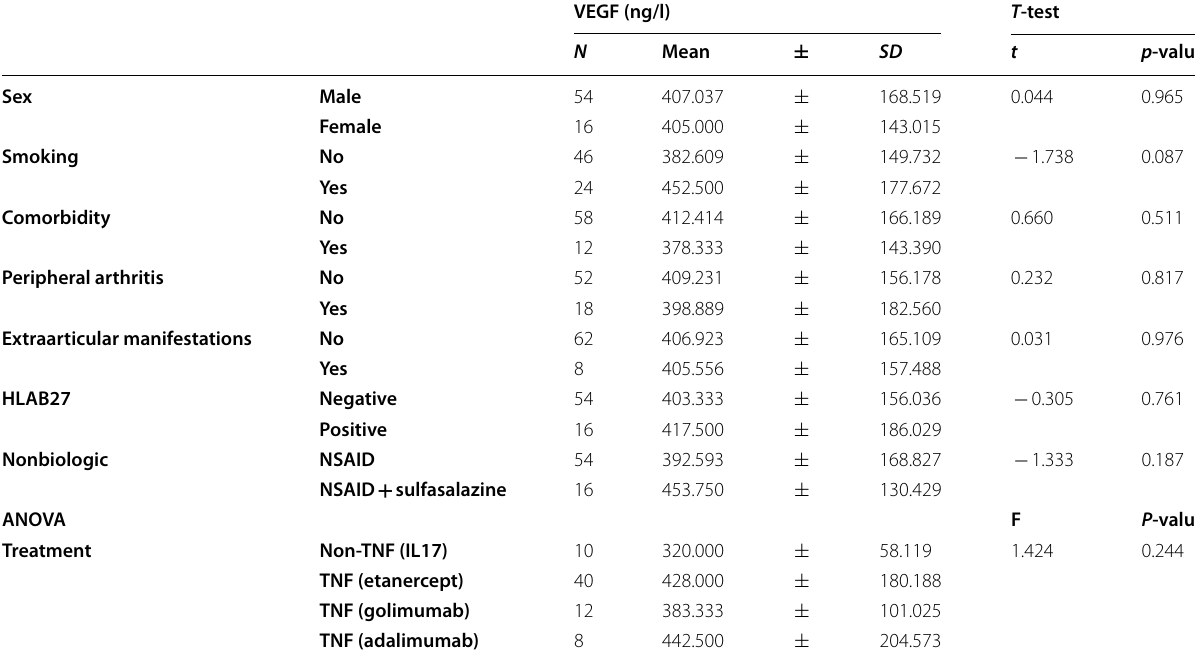
HLA Human leucocyte antigen, VEGF Vascular endothelial growth factor, ASDAS Ankylosing Spondylitis Disease Activity Score, NSAID Nonsteroidal anti-inflammatory drugs, TNF Tumor necrosis factor. SD Standard deviation P -values 0.05 are significant, and P -values 0.01 are highly significant ≤ ≤